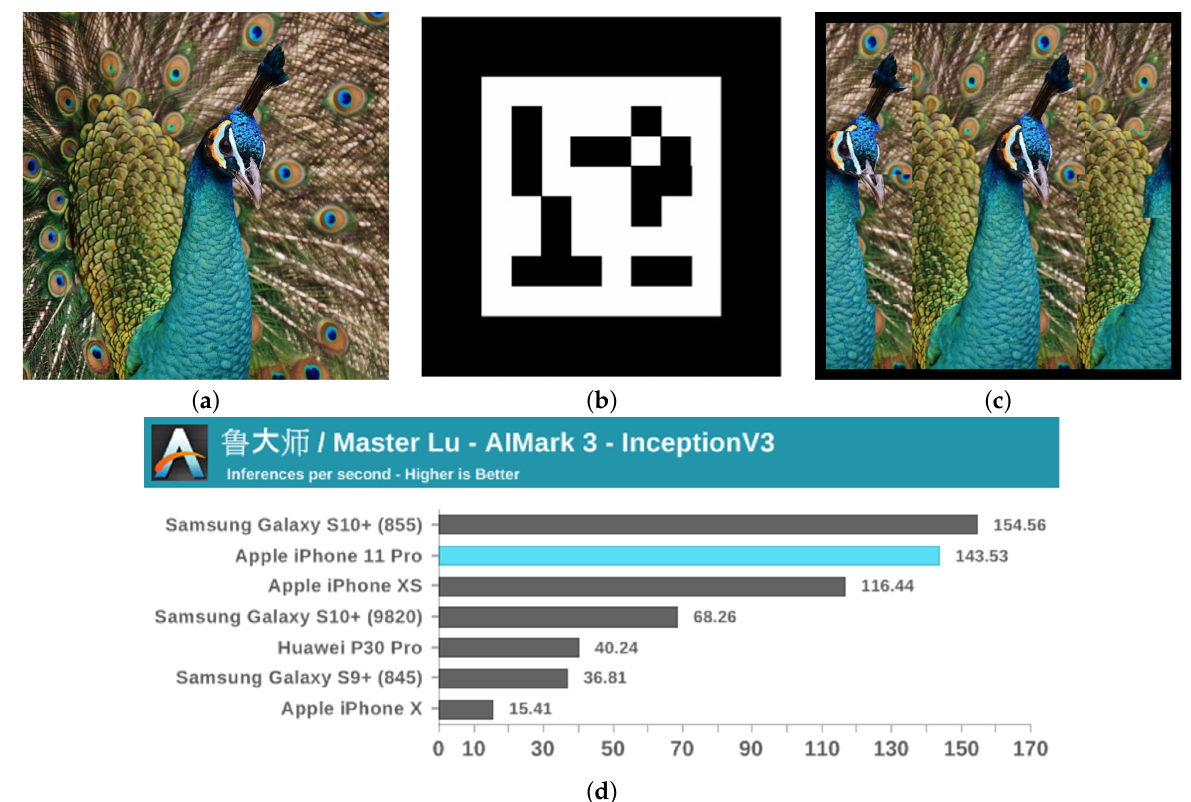
Figure 4. Augmented reality markers typically display unclear information and demand users to change the original picture in some way, either partially or completely ( a – c ). ( d ) depicts the performance of machine learning inference across several phone models using InceptionV3. ( a ) Template marker; ( b ) Bar-code marker; ( c ) Pictorial bar-code